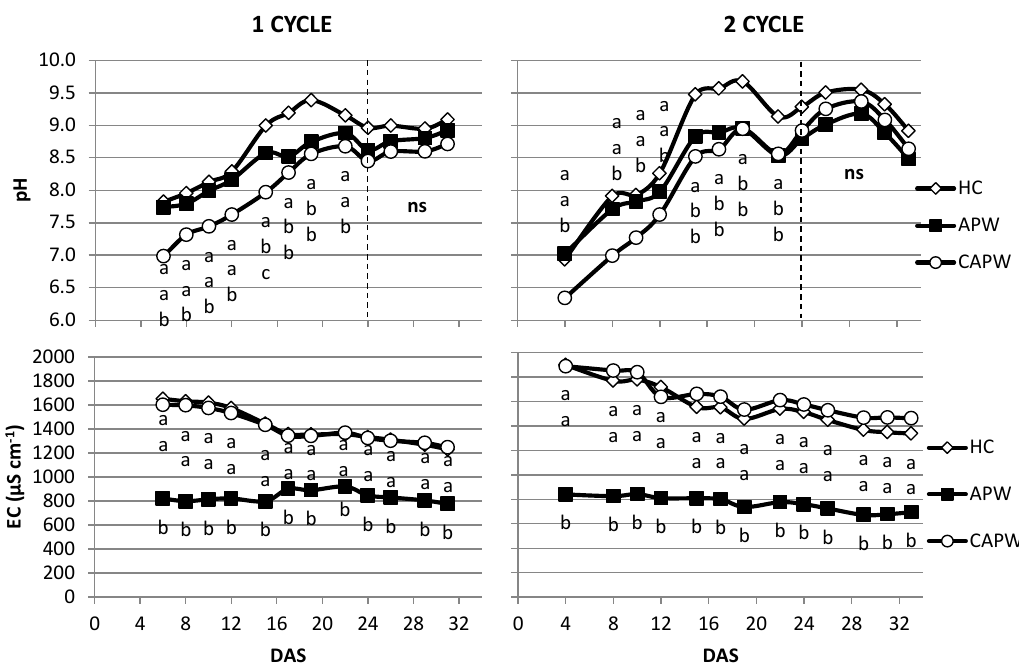
Figure 3. Effect of water treatment on pH and electric conductivity (EC) in both growth cycles. Values with different letters on the same day after sowing (DAS) are significantly different with p < 0.05, based on Tukey HSD Test. HC: hydroponic control; APW: aquaponic water; CAPW: complemented aquaponic water.